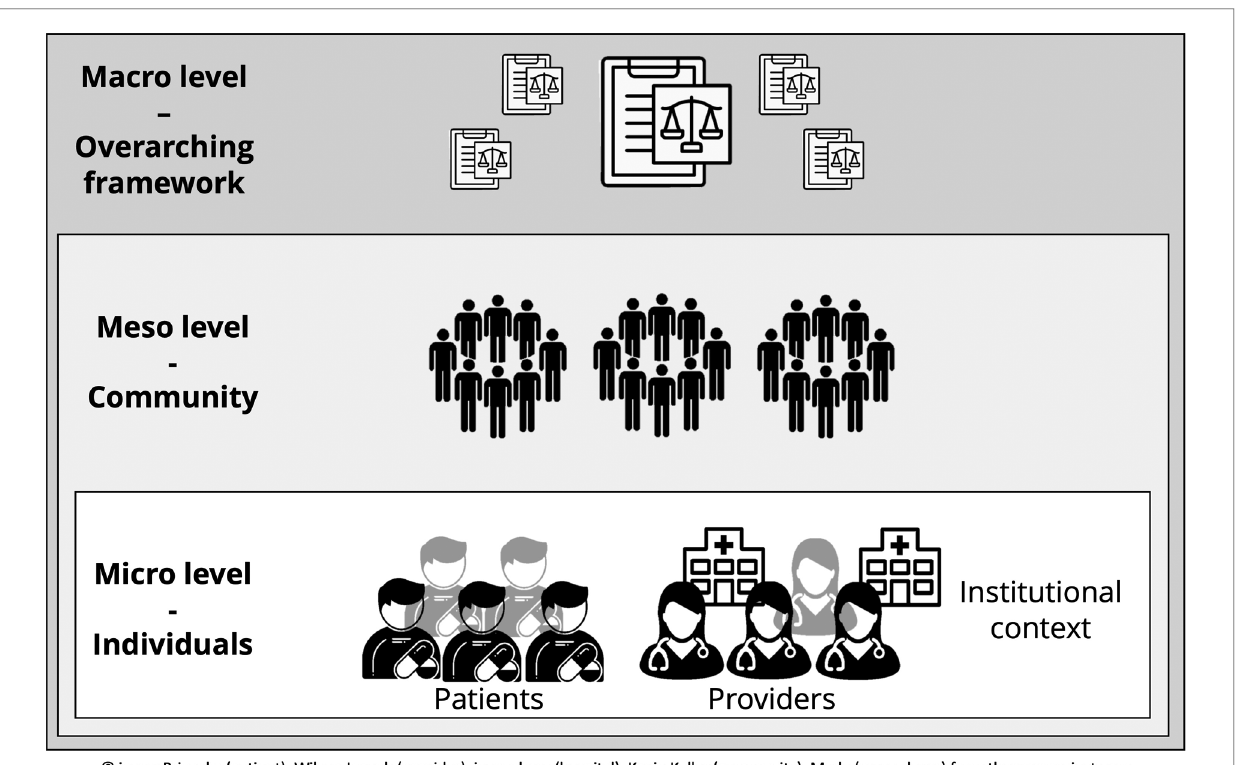
FIGURE 1 The wider societal context surrounding